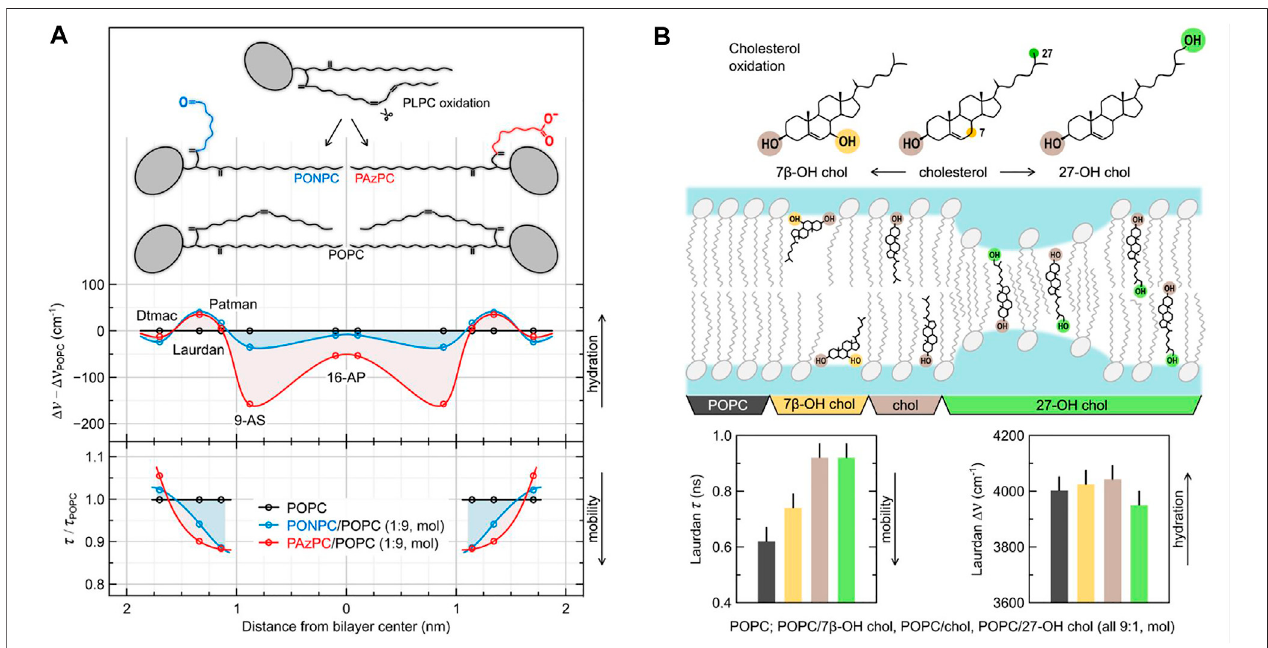
FIGURE2| TheeffectsofoxidationofmodellipidmembranesonlocalhydrationandmobilityprobedusingTDFS. (A) depictsthein fl uenceoftheadditionof10 mol%of truncatedoxidizedphospholipids(oxPLs)intoPOPCliposomes.Therelativechangesinhydrationandmobilitypro fi lesacrossthemembraneareobtainedbycomparing TDFS parameters measured in the absence and in the presence of oxPLs. They are presented based on the known or estimated locations of the used fl uorophores (Dtmac, Laurdan, Patman, 9-AS, and 16-AP). The schematic structures of the lipid molecules are presented in scale. (B) depicts the in fl uence of the addition of 10 mol% of cholesterol and two of its oxidation products into POPC liposomes. Position of the sterol molecules within the bilayer are schematically portrayed based on molecular dynamics simulations, but the effects are exaggerated for the illustrative purposes. The TDFS result shown in the bar graphs are color coded. Experimental details can be found in the original publications the fi gure was adopted from (Volinsky et al., 2011; Kulig et al., 2015b).